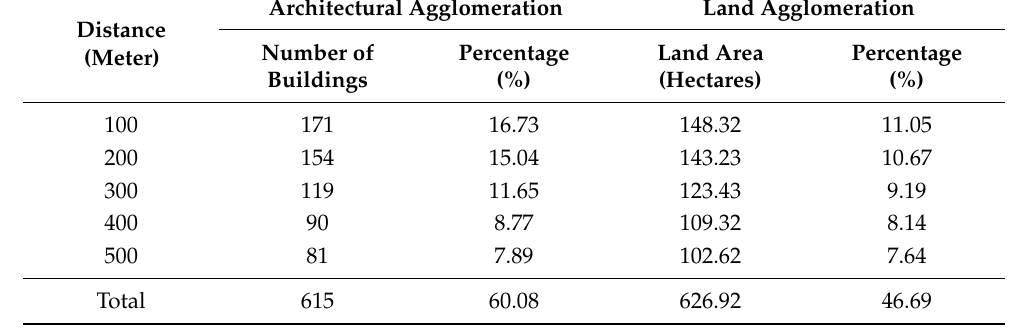
Figure 5. Distribution of trunk road in the inner fringe of Guangzhou: ( a ) horizontal direction trunk road; ( b ) vertical direction trunk road.